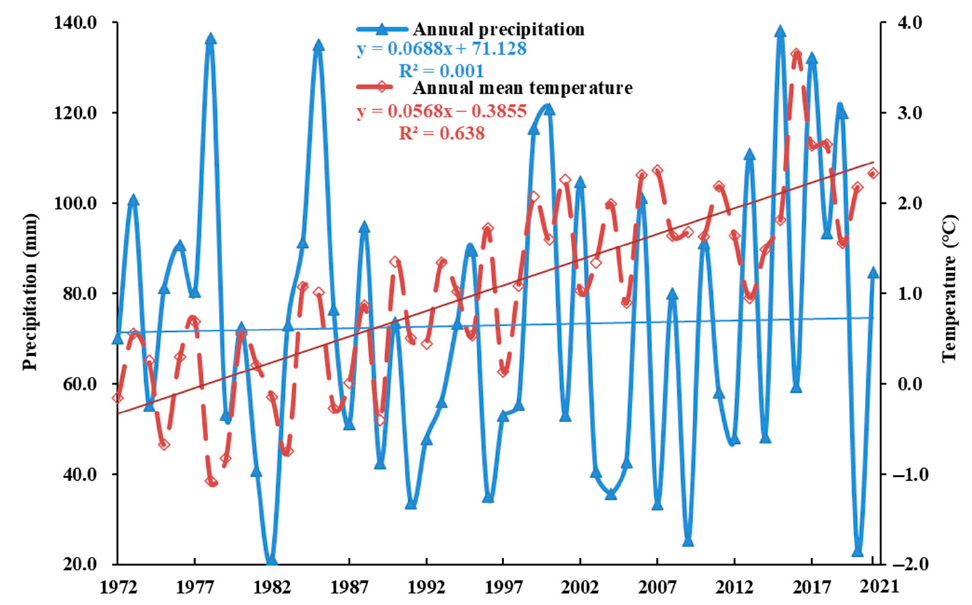
Figure 4. Changes in the annual mean temperature and annual precipitation around the study area during 1972–2021.